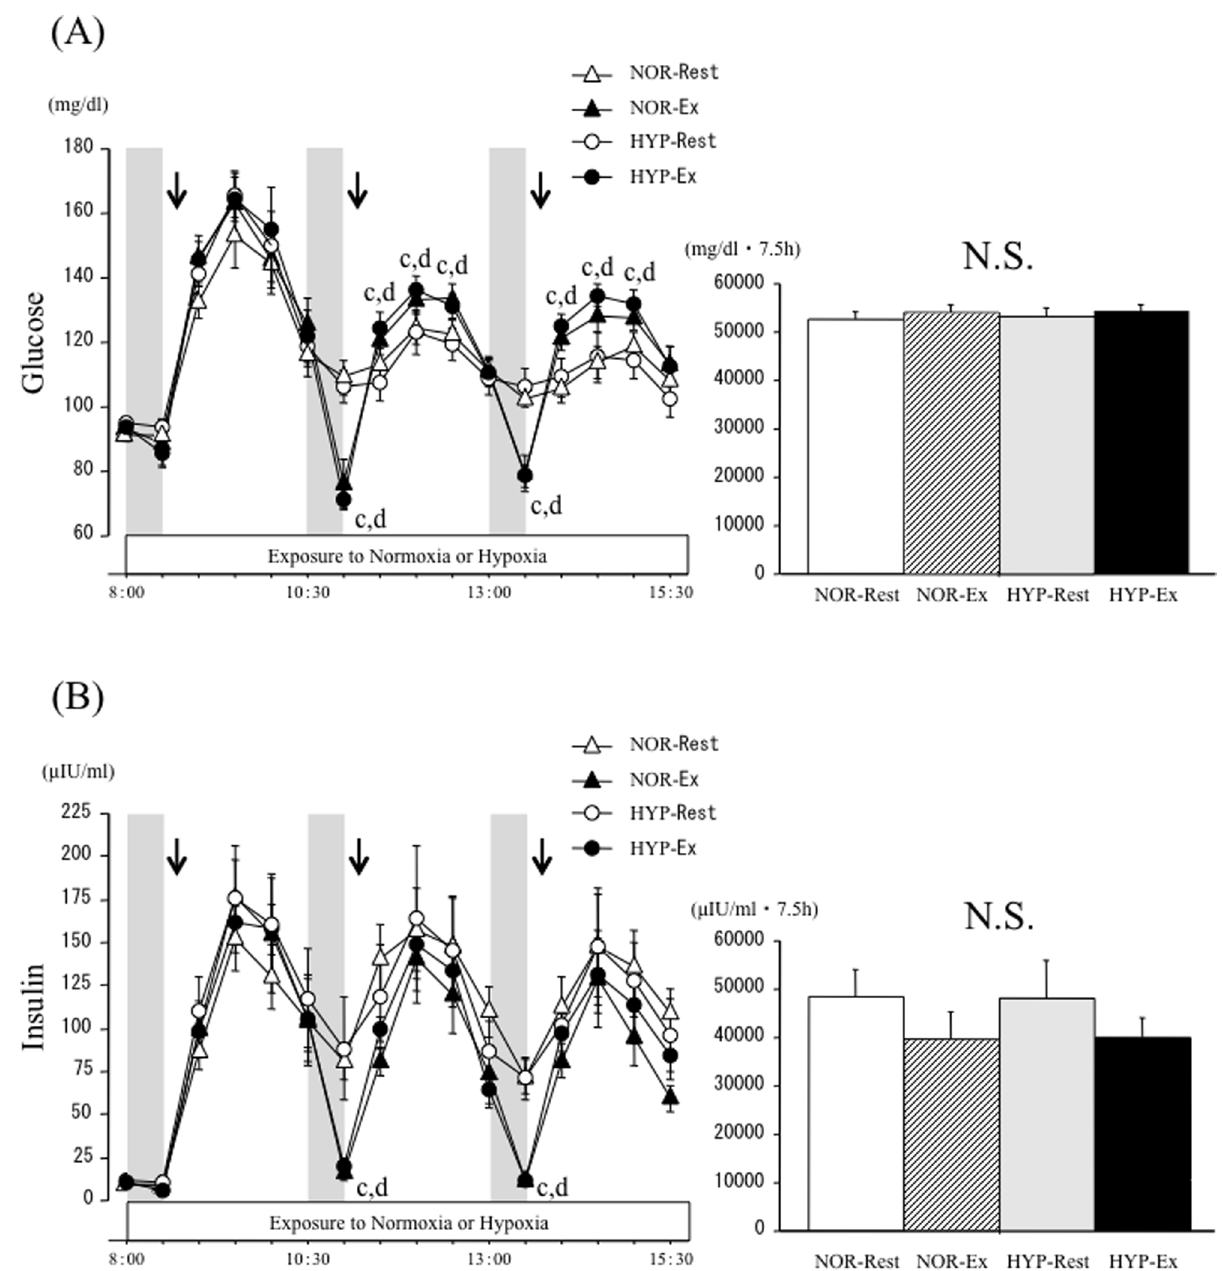
Figure 3. Time-course changes and area under the curve of blood glucose (A) and serum insulin (B) concentrations over 7.5 h. Each period of exercise is indicated by the shaded boxes. The arrow indicates the time of meal consumption. c; P , 0.05, NOR-Rest vs. NOR-Ex. d; P , 0.05, HYP-Rest vs. HYP-Ex.